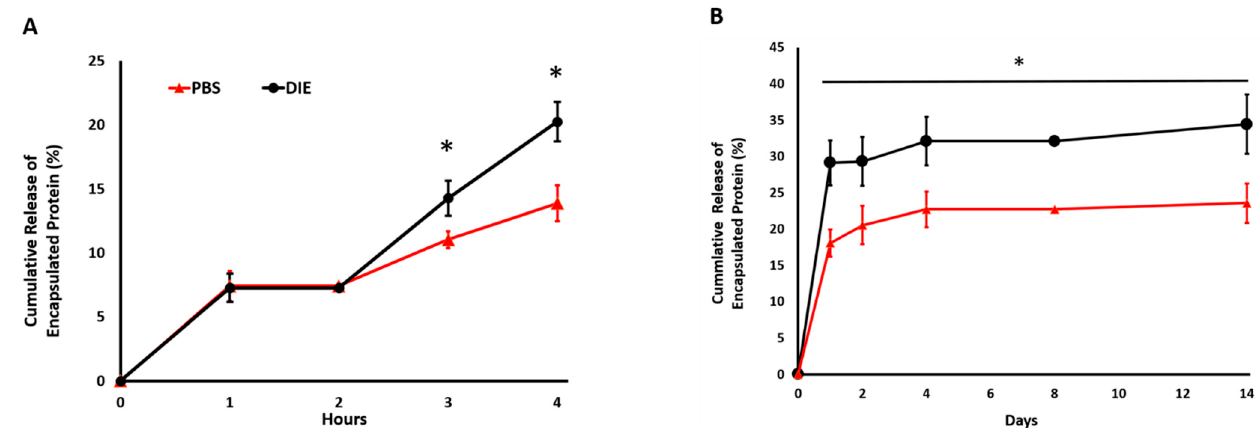
Figure 2. The role of digestive inflammatory environment (DIE) in model protein release profile from injectable scaffolds. ( A ) Model protein release profile within injectable scaffolds ( n = 4) cultured in phosphate buffer saline (PBS) and DIE during time = 0 to 4 h corresponding to the burst release phase and ( B ) over 14 days. * p < 0.05.